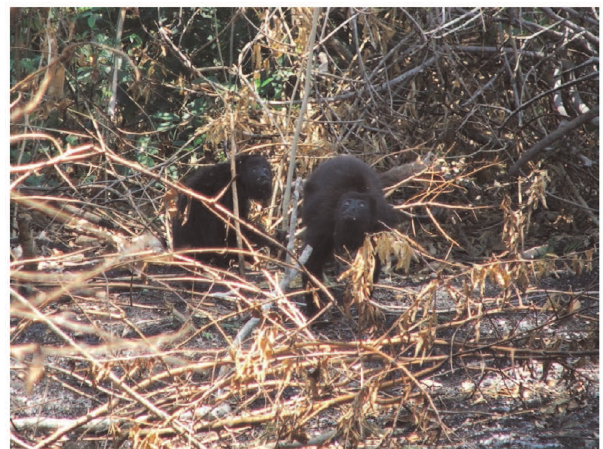
Figure 1. Black howler monkeys foraging on the ground in a recently burned forest fragment.